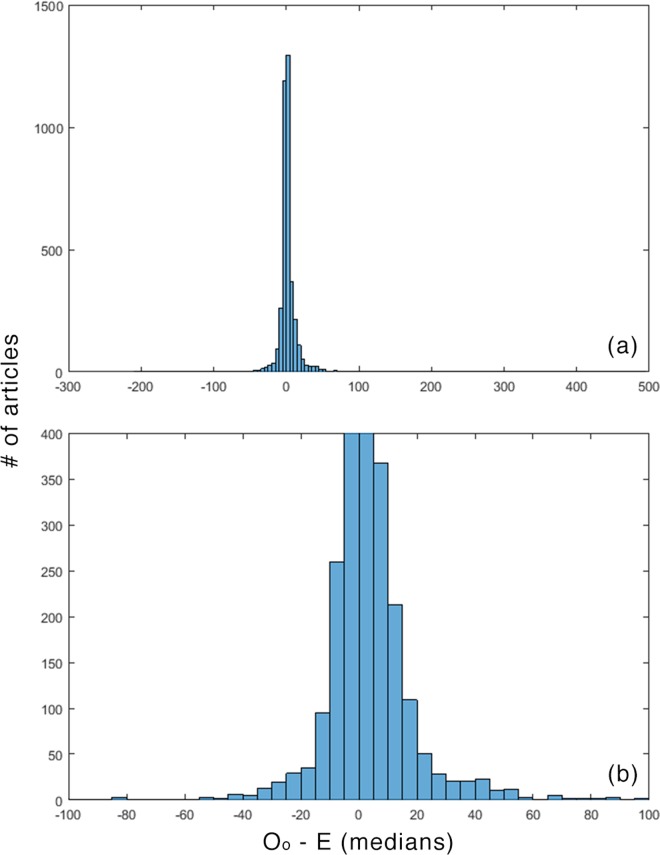
Oo—E for medians.(a) overall (b) detail.